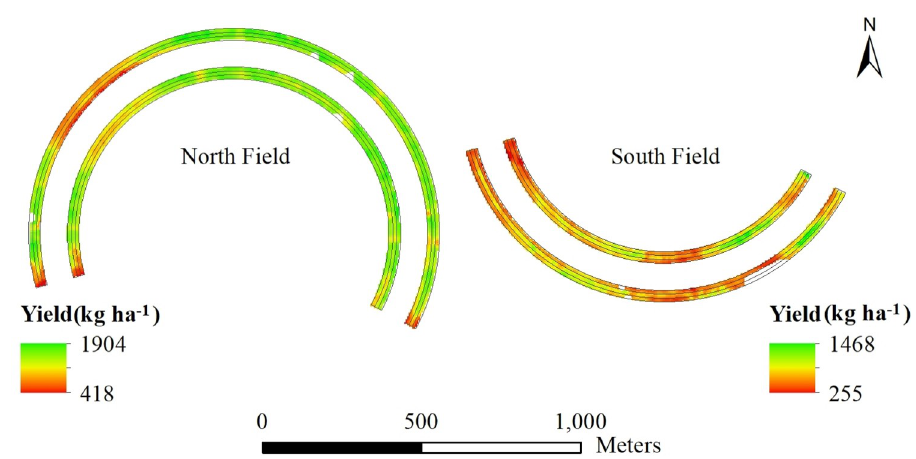
Fig 7. Variation in cotton lint yield for two fields within a 194-ha farm in Hale County, Texas, in 2017.